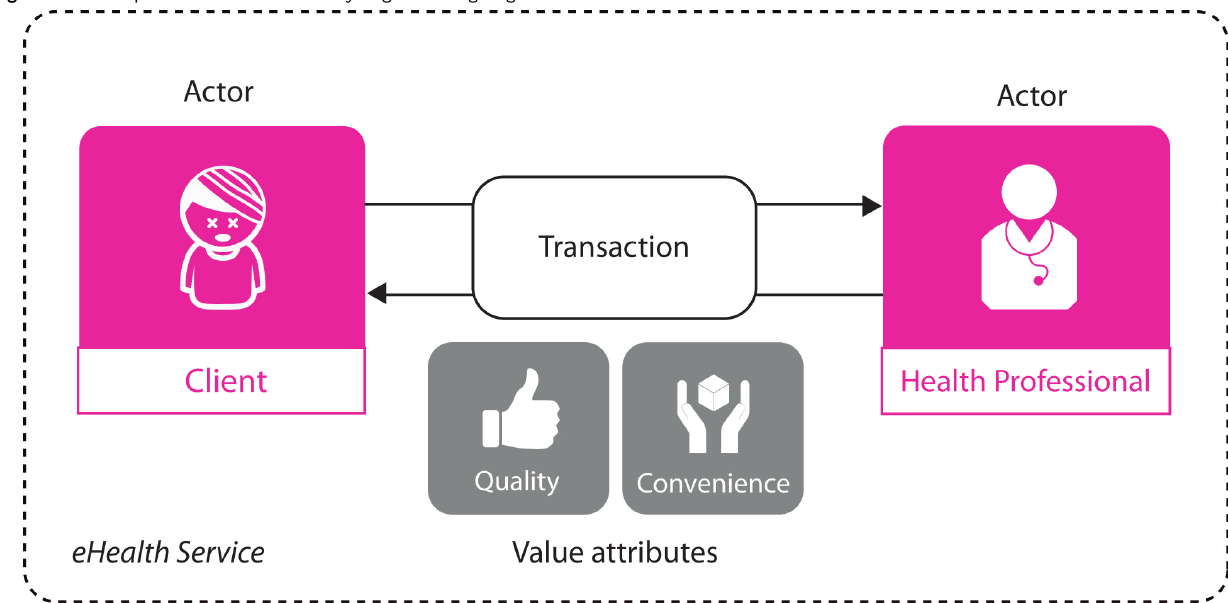
Figure 1. Conceptual framework for analyzing and designing a care